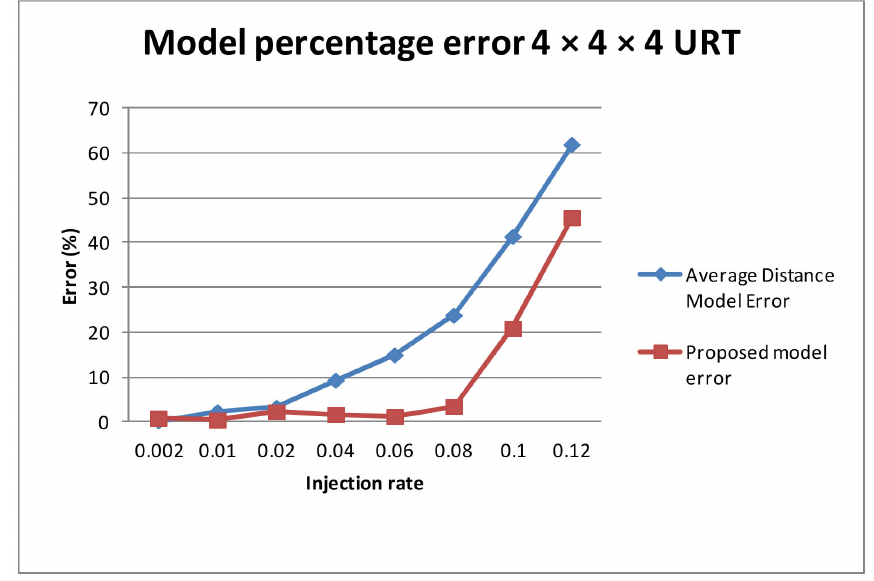
Figure 11. Percentage error vs. injection rate comparison between the proposed and the average distance model for 4 × 4 × 4 topology and uniform random